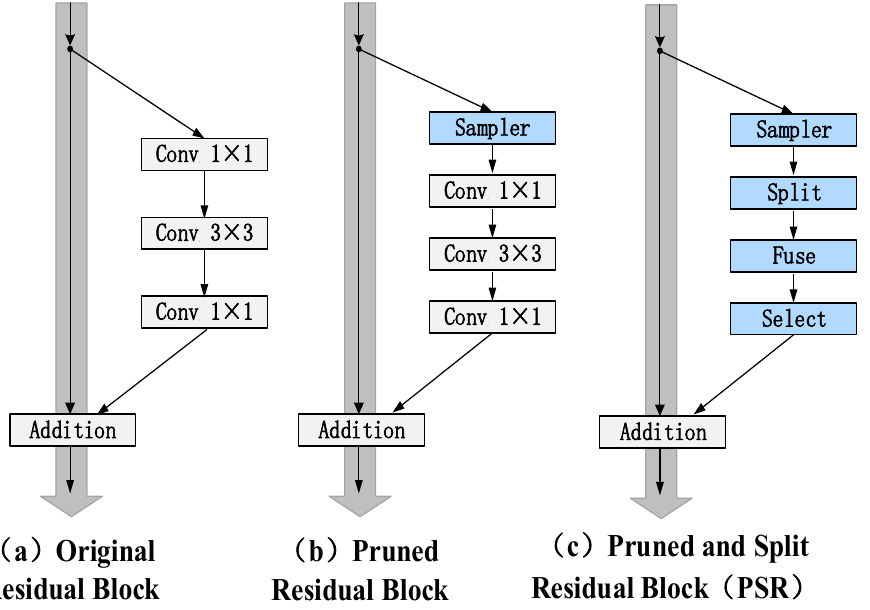
Figure 2. The proposed residual units. ( a ) represents the original residual block. ( b ) represents the pruning of the residual block. The input channel of the first convolution layer is sampled, and the rest is operated according to Section 3.2. ( c ) means to extend the width of the residual block. The specific operation is also in accordance with Section 3.2. The blue square indicates the difference between the proposed method and the original residual block.